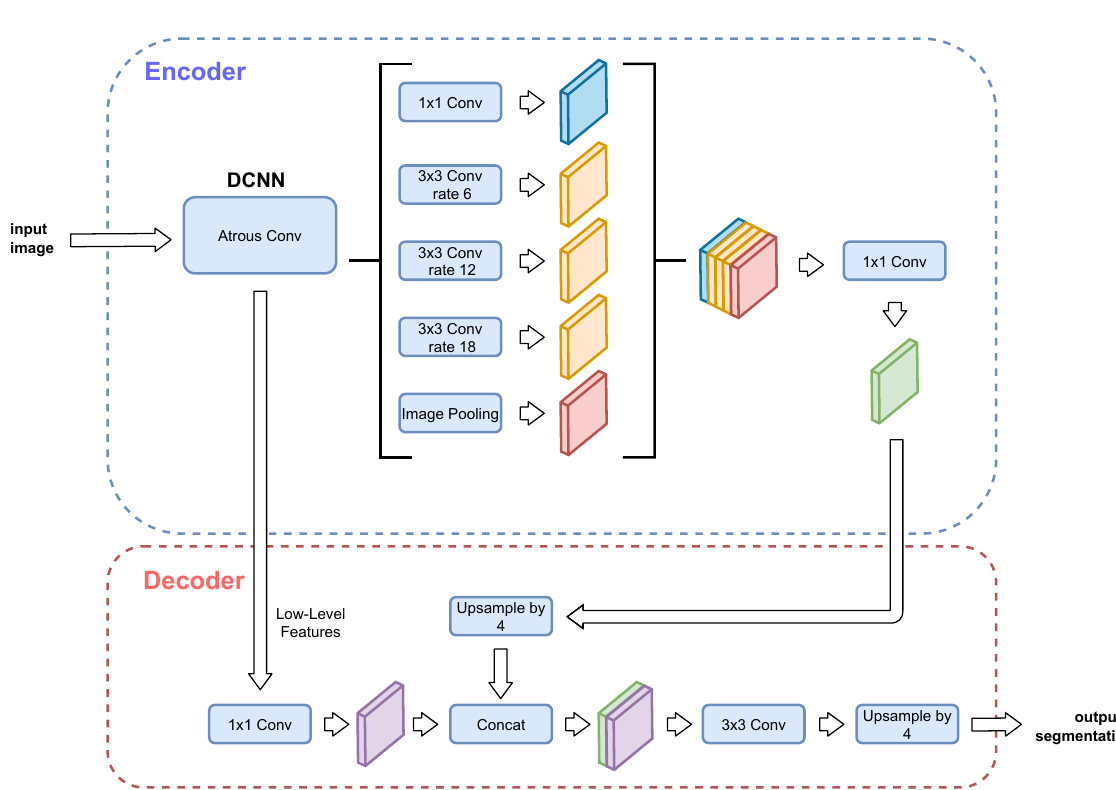
Figure 6. DeepLabV3+ architecture. A backbone network such as ResNet-101 or Xception65 can be used as DCNN. This diagram is based on the original DeepLabV3+ publication